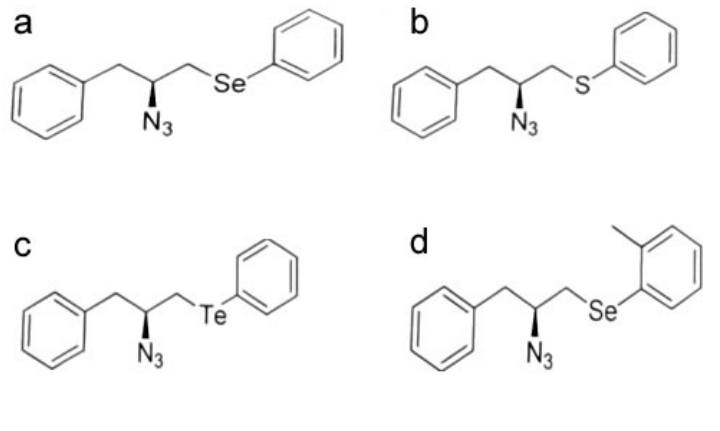
Figure 1. Chemical structures of β-aryl- chalcogenium azide compounds (a) S601AZ (b) S602AZ (c) S603AZ and (d)